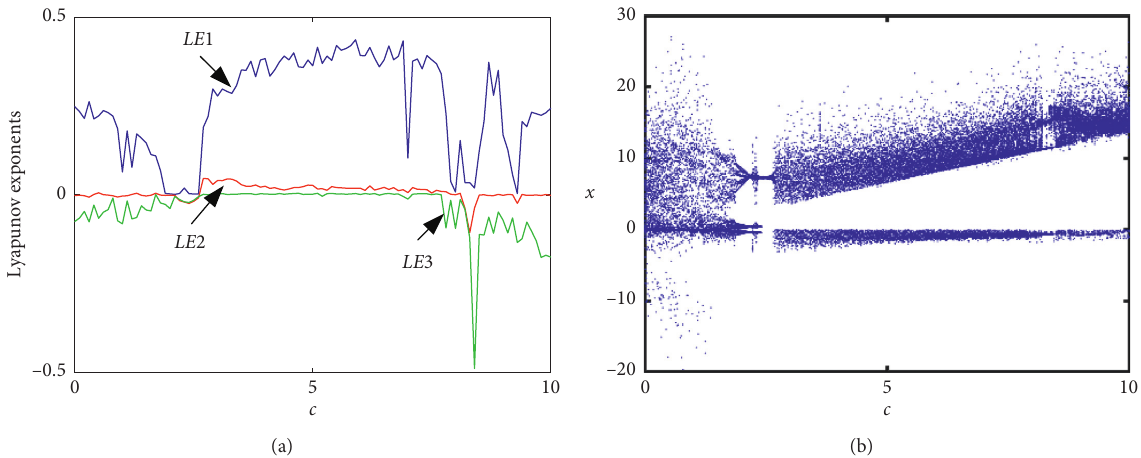
Figure 8: Lyapunov exponent spectra and bifurcation diagram of system (4) with a � 2, b � 3, d � 0.75, and k � 1, while c varies in [1, 10]: (a) Lyapunov exponent spectra: LE 1 is blue, LE 2 is red, and LE 3 is green; (b) bifurcation diagram.